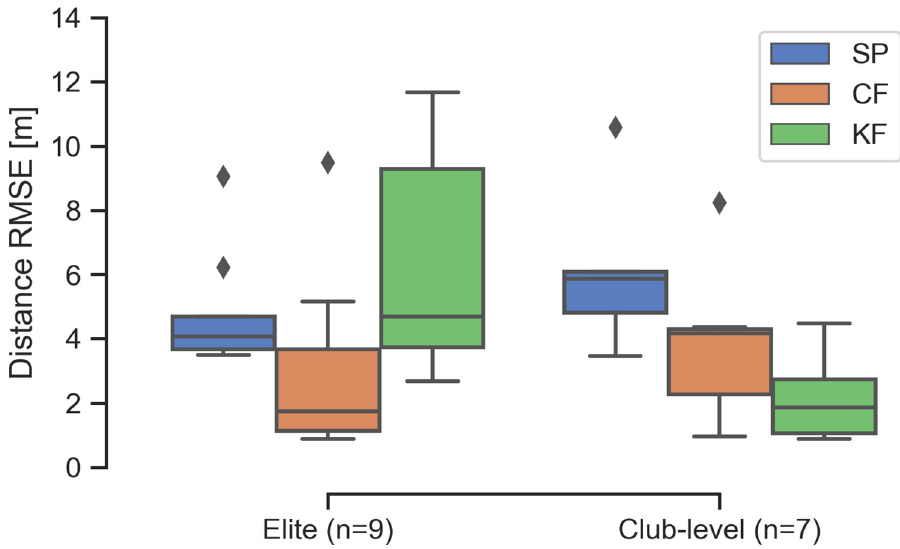
Fig 13. Summary of the distance estimate errors for all trials. Comparisons of the distributions of RMSE distance estimates from the three methods for the last 10 strokes of each